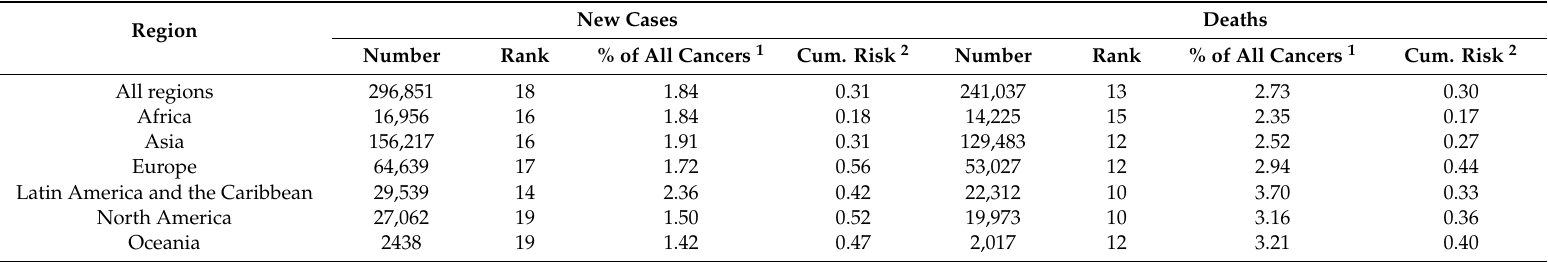
Table 1. Summary of the number of cases, rank and percentage of brain and nervous system in all cancers in the selected regions. New Cases Deaths Region Number Rank % of All Cancers 1